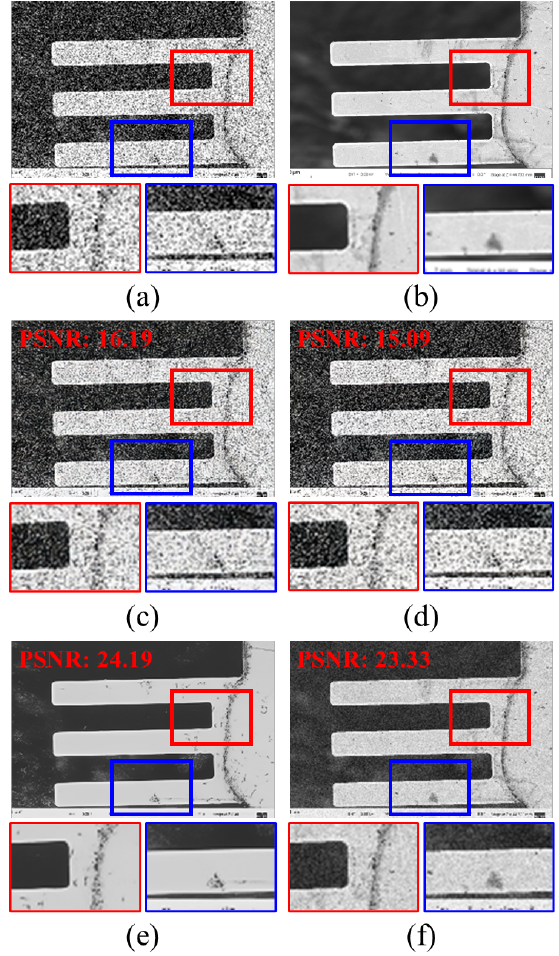
Figure 9. Visual comparison of other denoising algorithms: ( a ) input noisy LR image, ( b ) target clean LR image, and denoising by ( c ) FFDNet, ( d ) SwinIR, ( e ) Restormer non-blind model (trained with a fixed noise variance of 50), and ( f ) average